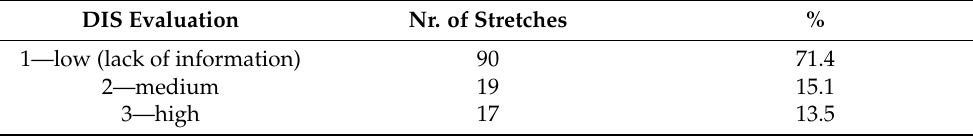
Table 11. Diversity of information signs